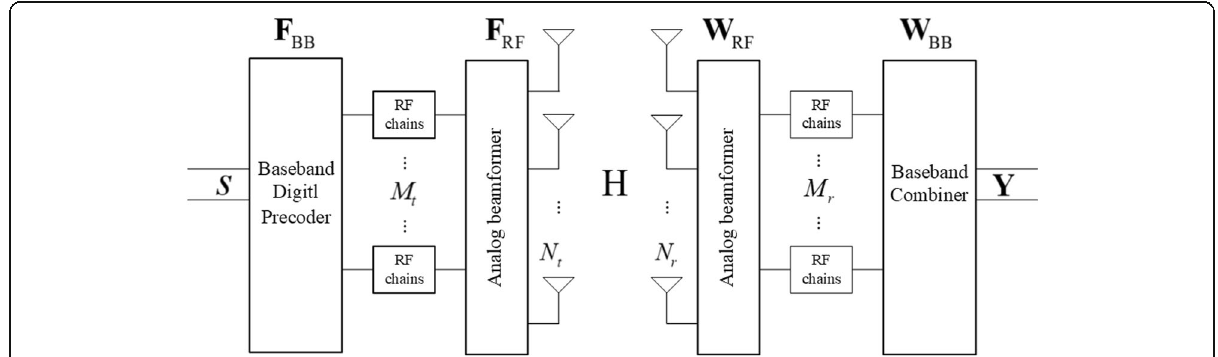
Fig. 1 Illustration of a hybrid analog/digital precoding and combing structure. The picture illustrates a mm-wave communication system equipped with hybrid analog/digital